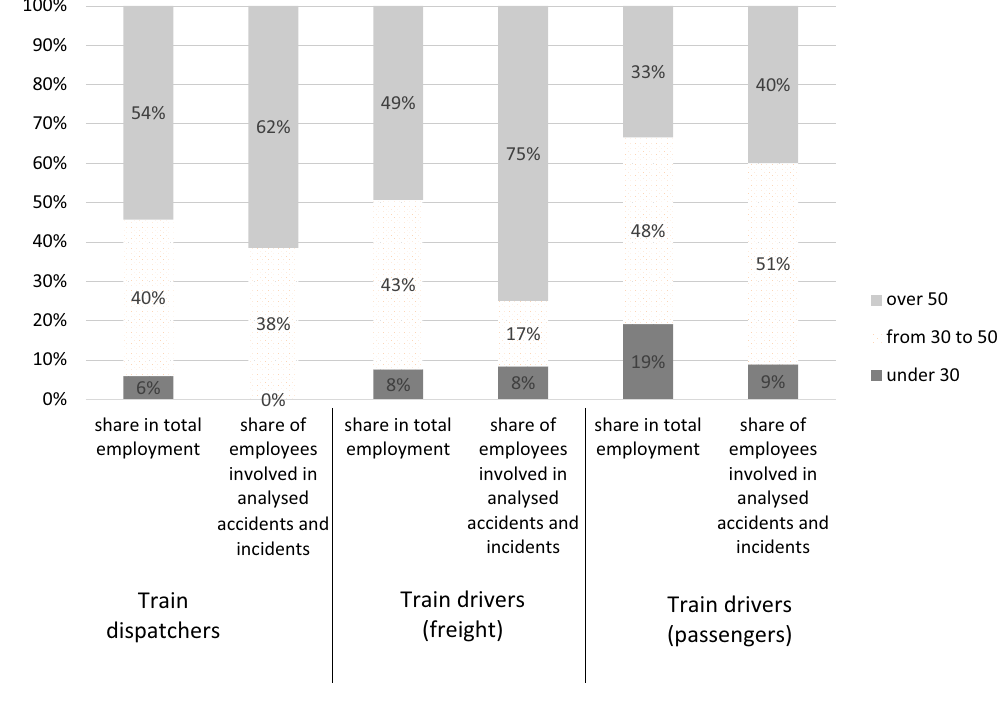
Figure 2: Age distribution of railway employees [ 17,19 ]